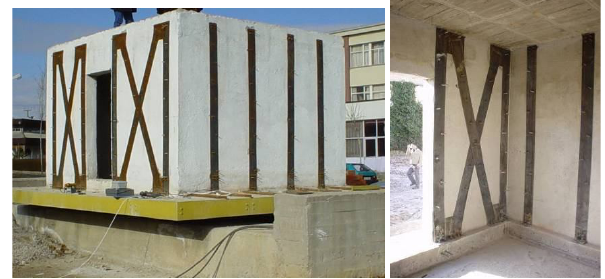
Fig. 15 Outer and inner steel strips (Altın, 2005, Altin, 2008)